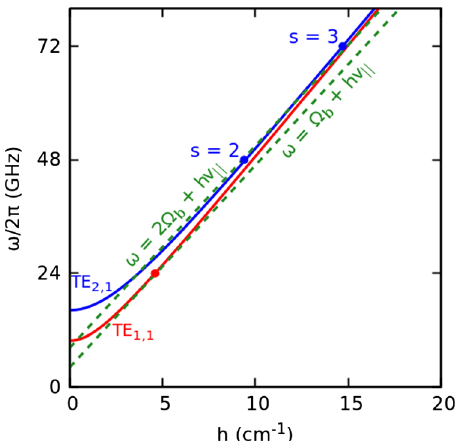
FIG. 2. Dispersion diagram illustrating the rf wave/e-beam interaction in the FEM multiplier. The solid lines correspond to the operating TE 1 ; 1 and TE 2 ; 1 modes and the dashed lines show the electron beam dispersion